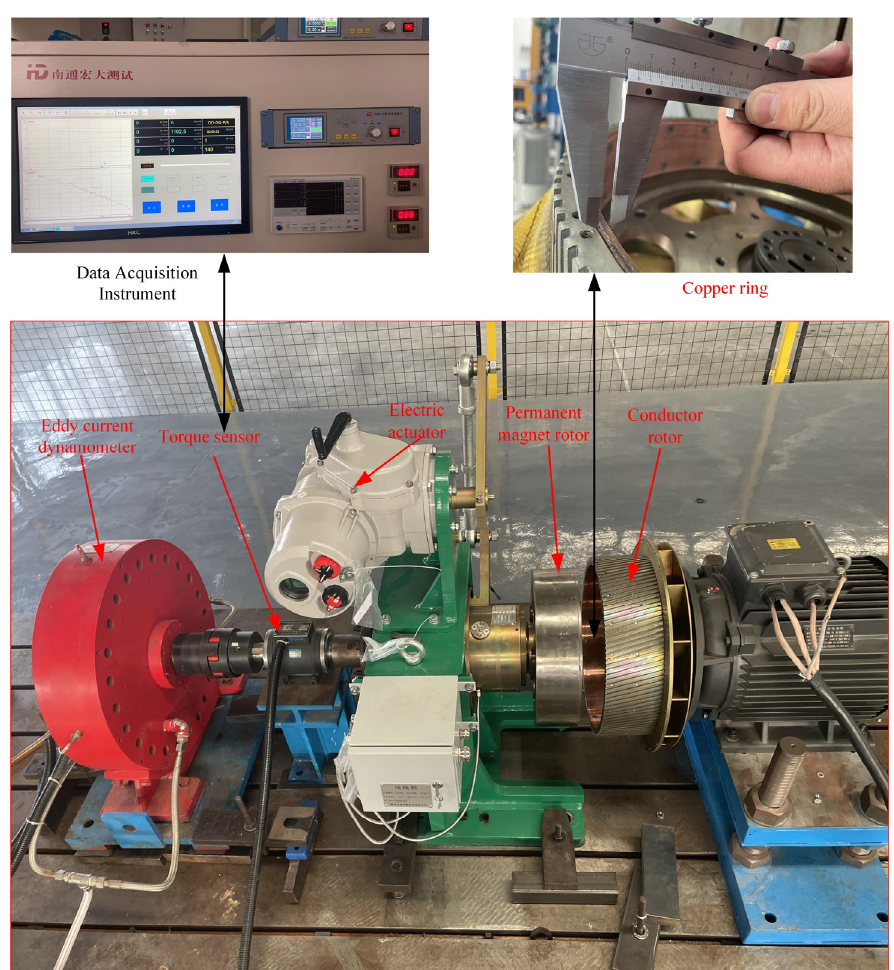
Figure 16. Test prototype construction.